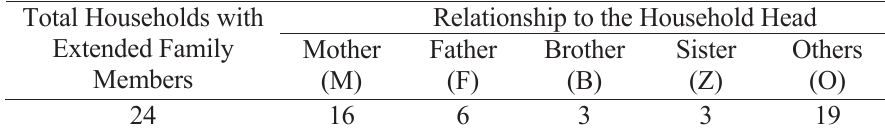
Table 1. Households with Extended Family Members